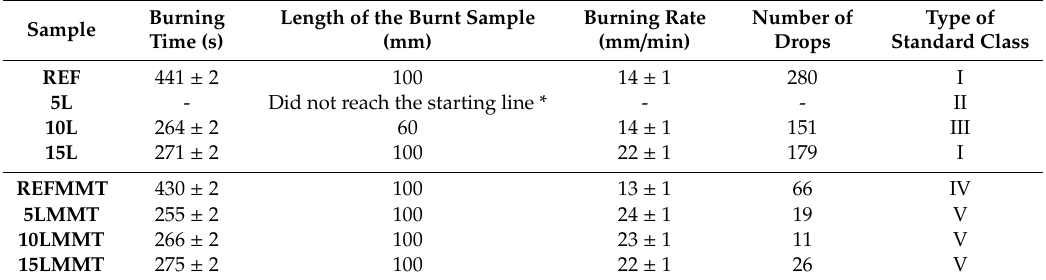
Table 3. Results of the UL-94 combustion carried out in a horizontal position (HB) for the composites covered by using the LbL